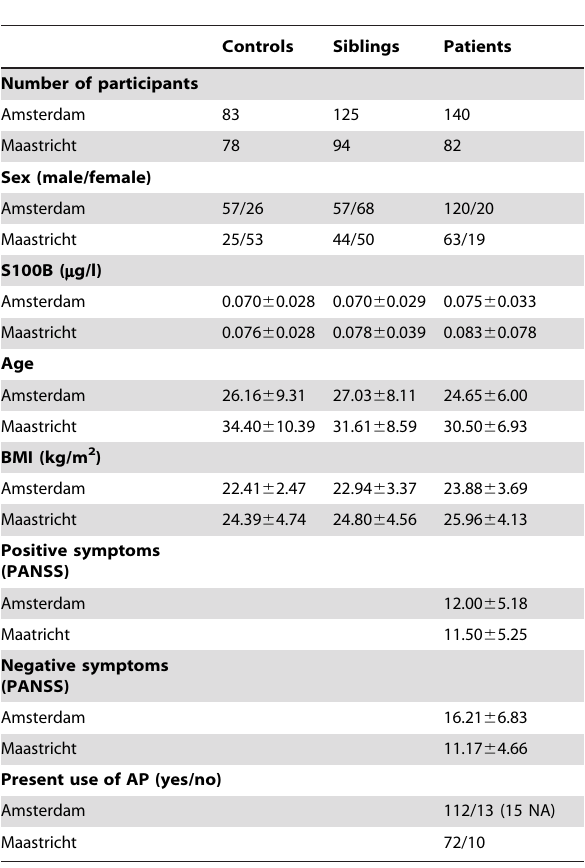
Table 1. Demographic